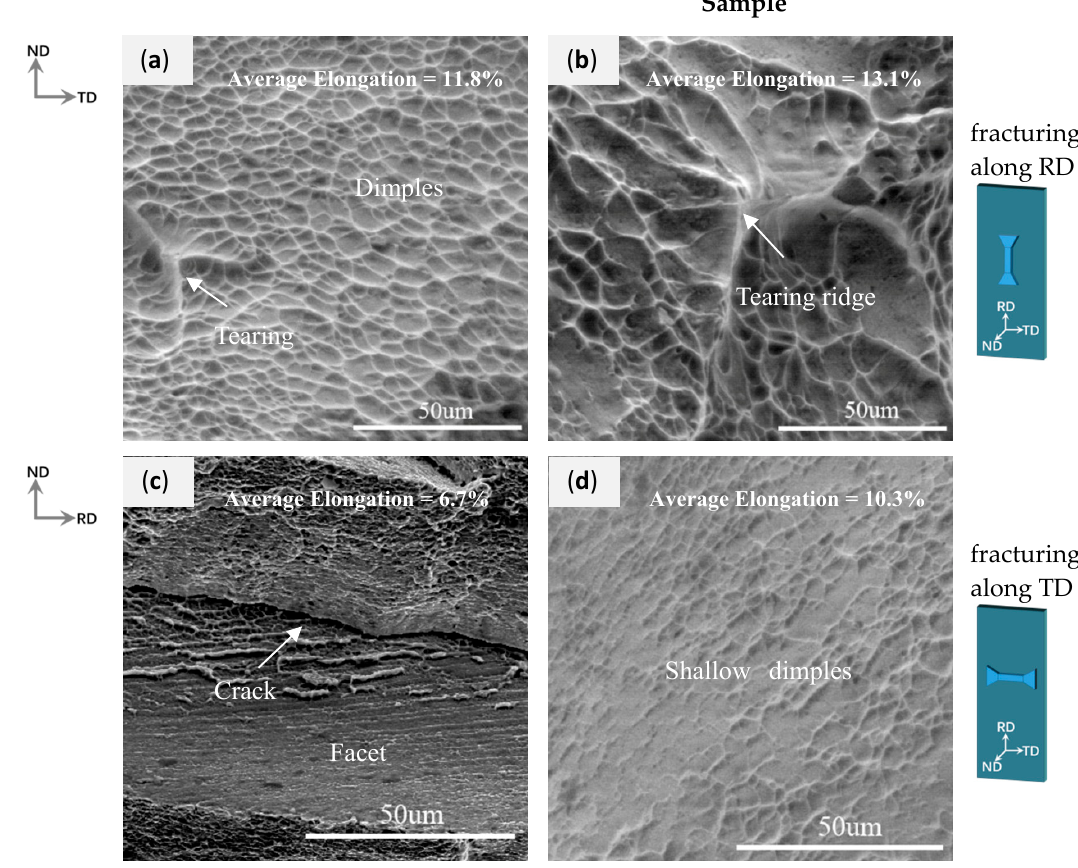
Figure 9. Fracture surfaces of HR and HR+HT samples after tensile tests. ( a , b ): ND-TD surface; ( c , d ): ND-RD surface.